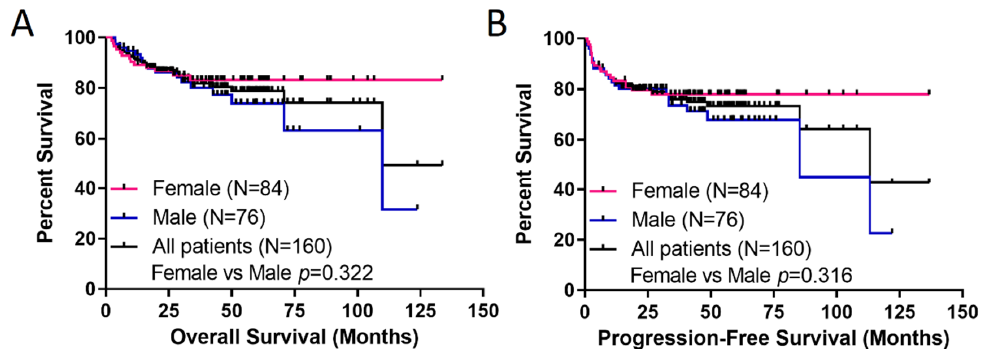
Figure 1. Survival of the DLBCL Patient Cohort. ( A ) Overall Survival and ( B ) Progression-Free Survival. Survival is plotted for all patients as well as females and males, individually. p -value (comparing female vs. male survivals) was calculated with the log-rank test.